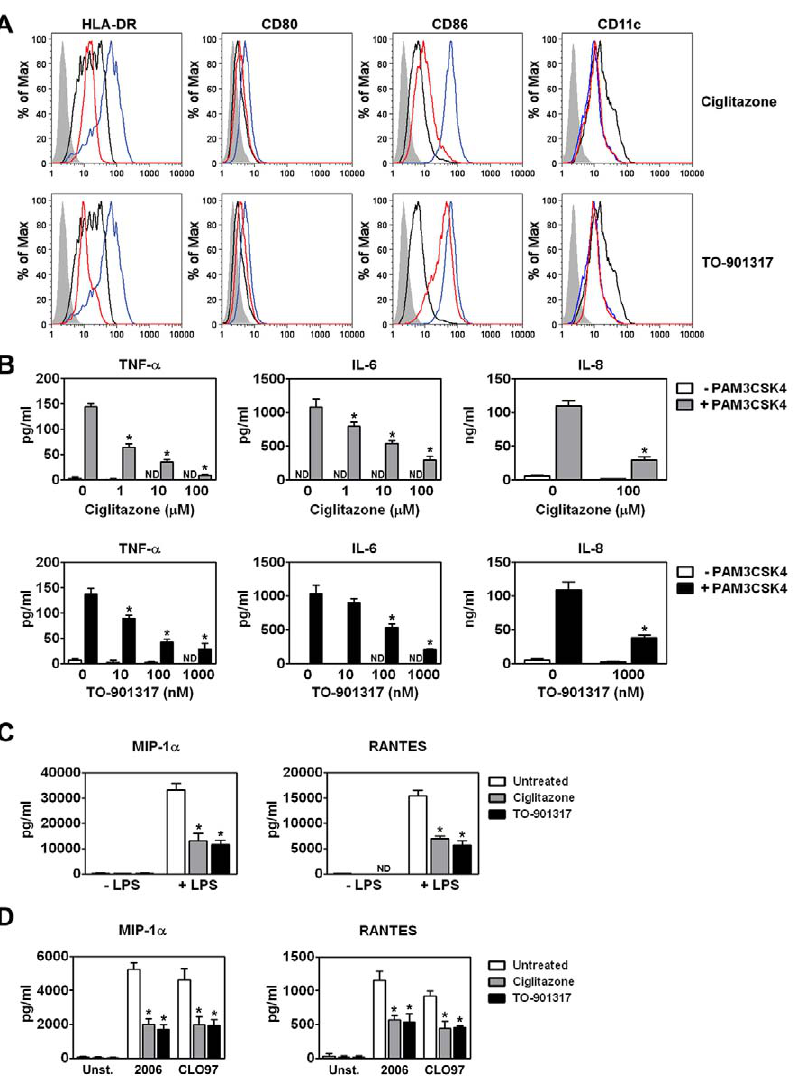
Figure 1. PPAR c and LXR ligand treatment prevents MDDC maturation and pro-inflammatory cytokine production. (A) MDDCs were treated with LPS for 48 hours in the presence or absence of the PPAR c ligand ciglitazone (100 m M; upper panel) or the LXR ligand TO-901317 (1 m M; lower panel). NR ligands were added one hour prior to TLR ligand addition. MDDCs were then stained for surface expression of HLA-DR, CD80, CD86, and CD11c and analyzed by flow cytometry. Shaded histogram, isotype control. Black line, iMDDCs. Blue line, LPS-treated MDDCs. Red line, LPS and nuclear receptor ligand-treated MDDCs. (B) MDDCs were treated with PAM3CSK4 in the presence or absence of 100 m M ciglitazone (upper panels) or 1 m M TO-901317 (lower panels). Cell-free supernatants were analyzed for TNF- a , IL-6, and IL-8 by ELISA. (n=3) (C) MDDCs were treated with 100 ng/ ml LPS in the presence or absence of 100 m M ciglitazone or 1 m M TO-901317. Cell-free supernatants were analyzed for MIP-1 a and RANTES. (n=3) (D) pDCs were treated with 5 m M CpG ODN 2006 or 1 m g/ml CLO97 in the presence or absence of 100 m M ciglitazone or 1 m M TO-901317. Cell-free supernatants were analyzed for MIP-1 a and RANTES. (n=4). * p , 0.001 compared to TLR ligand-treated controls; ND, not detected.